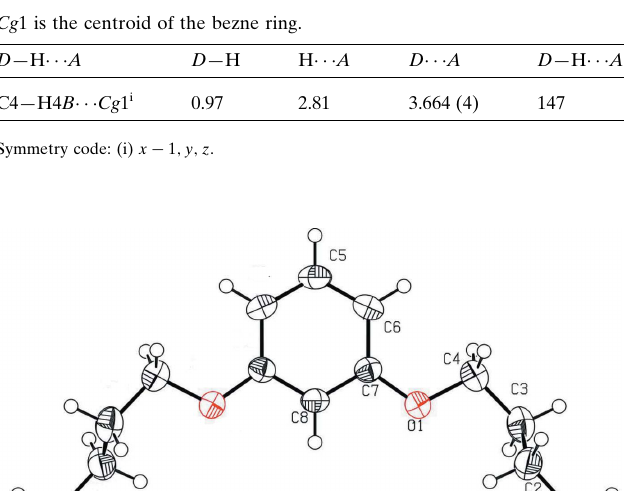
Table 2 Experimental details.